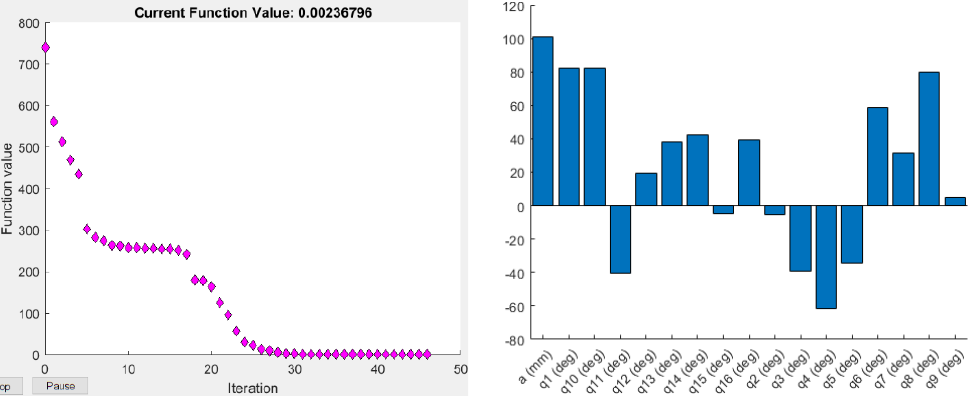
Figure 9. Objective function values ( left ), and the corresponding optimised joint parameters ( right ) for the best objective function value obtained by Fmincon for the IK optimisations.